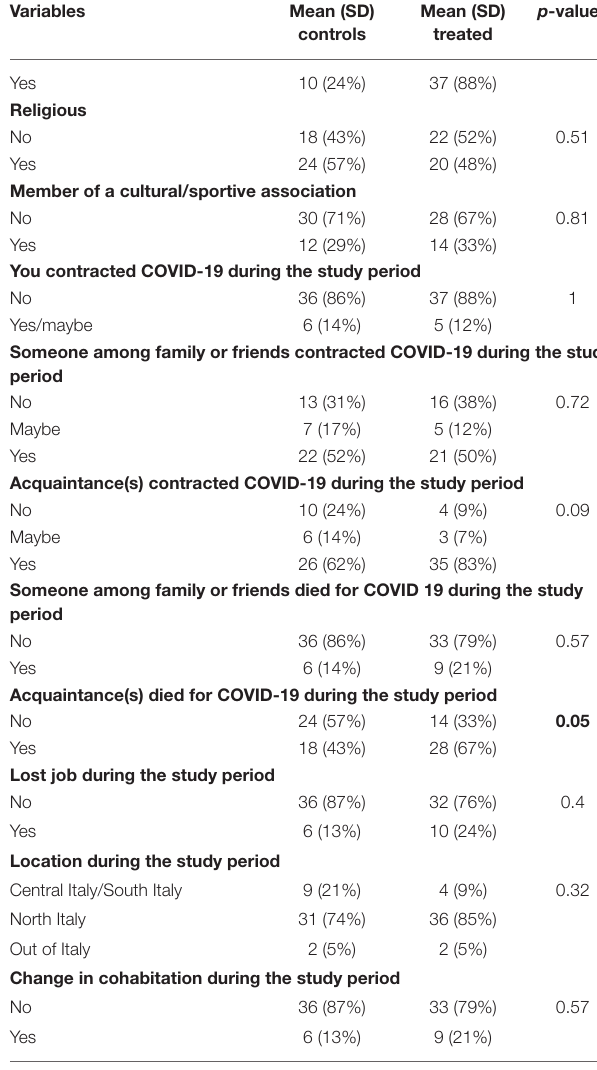
TABLE 1 | Baseline characteristics of the analyzed sample (treated = 42, controls =